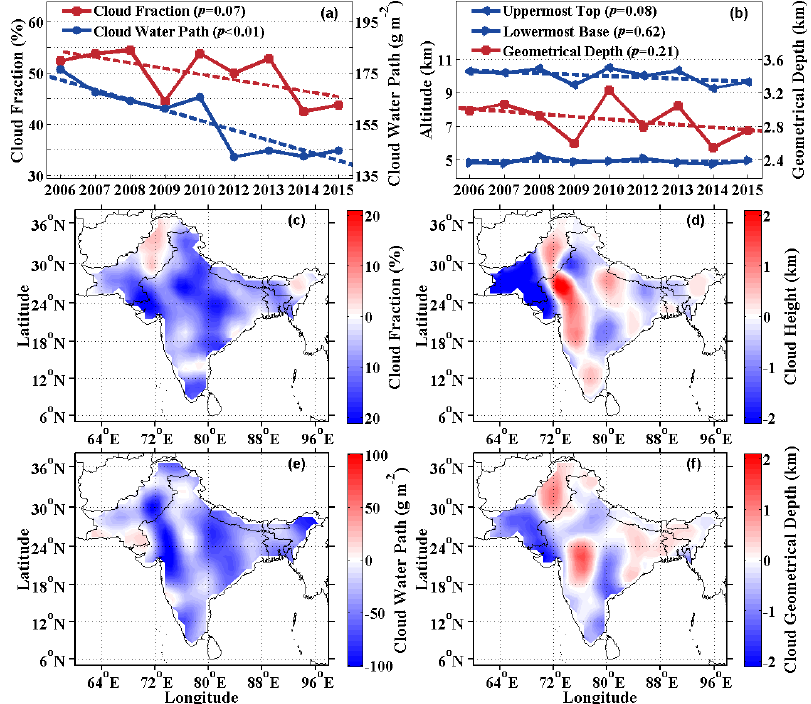
Figure 3. Temporal variations in spatial average ( a ) cloud fraction and CWP, as well as ( b ) uppermost CTH, lowermost CBH and CGD; spatial distributions of the temporal changes in average ( c ) cloud fraction, ( d ) CH, ( e ) CWP, and ( f ) CGD from CloudSat during the monsoon season in South Asia from 2006 to 2015. The dashed lines indicate the linear fit line of the solid line with the same color; p is the significance